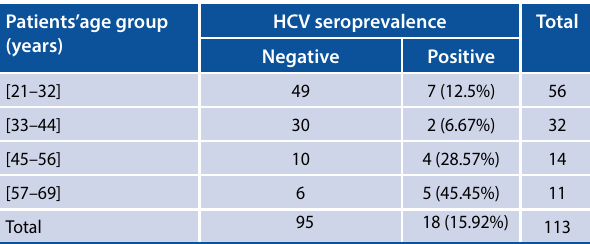
X 2 = 11.56, p = 0.009, Mean = 35.89, SD = ± 1.23.